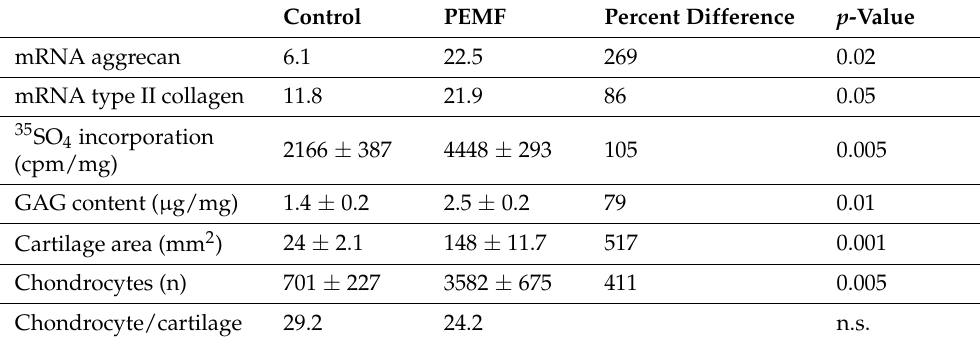
Table 2. Increased expression of cartilage genes with PEMF exposure. Gene expression normalized to GAPDH shows a 3-fold increase in aggrecan expression on both days 6 and 8 of development and a 2-fold increase in collagen II on day 8 with PEMF exposure. The aggrecan gene typically resolves into 2 bands, which is why both the 7.4 and 8.0 kb variants were seen. Both variants exhibited a 3-fold increase in expression with PEMF exposure. Adapted with permission from Ref. [9]. 2002, Journal of Orthopaedic Research . Aggrecan (kb) Control Day 6 Exposed Control Day 8